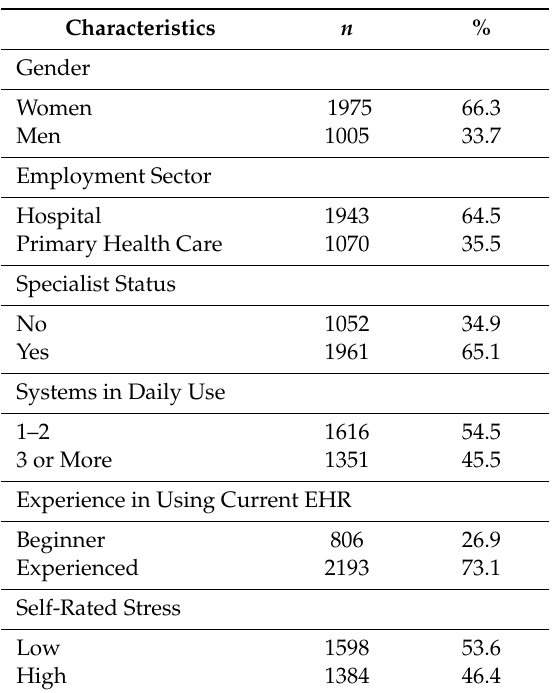
Table 1. Characteristics of the study